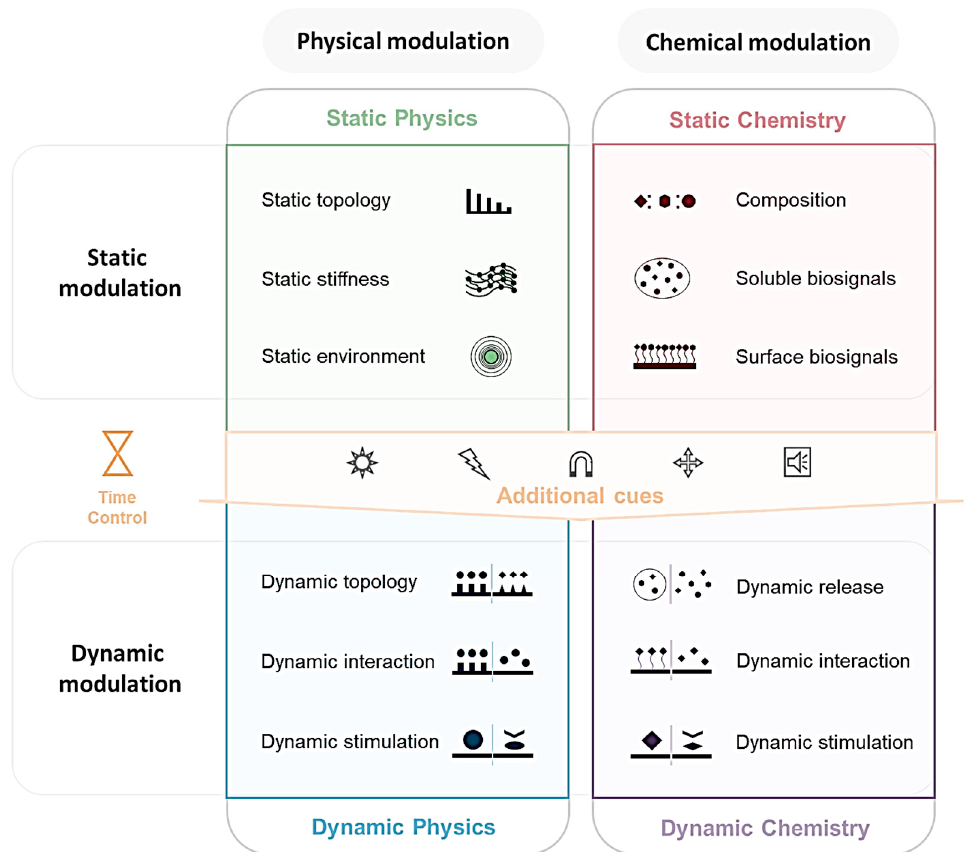
Figure 2. Methods of controlling biomaterials for cell modulation. Biomaterials can be classified as physical-oriented or chemical-oriented depending on their effects on cells. They can then be further classified as static or dynamic. Typical examples of static-physical modulation include static topology, static stability, and static environment (e.g., temperature, electrical/magnetic field), while examples of static-chemical modulation include chemical composition, solid biosignals, and surface-immobilized biosignals. Dynamic modulation enables surface property change, dynamic release, dynamic interaction, and dynamic stimulation through additional cues, such as light, electric/magnetic fields, ultrasonic, and deformation, based on static modulation.